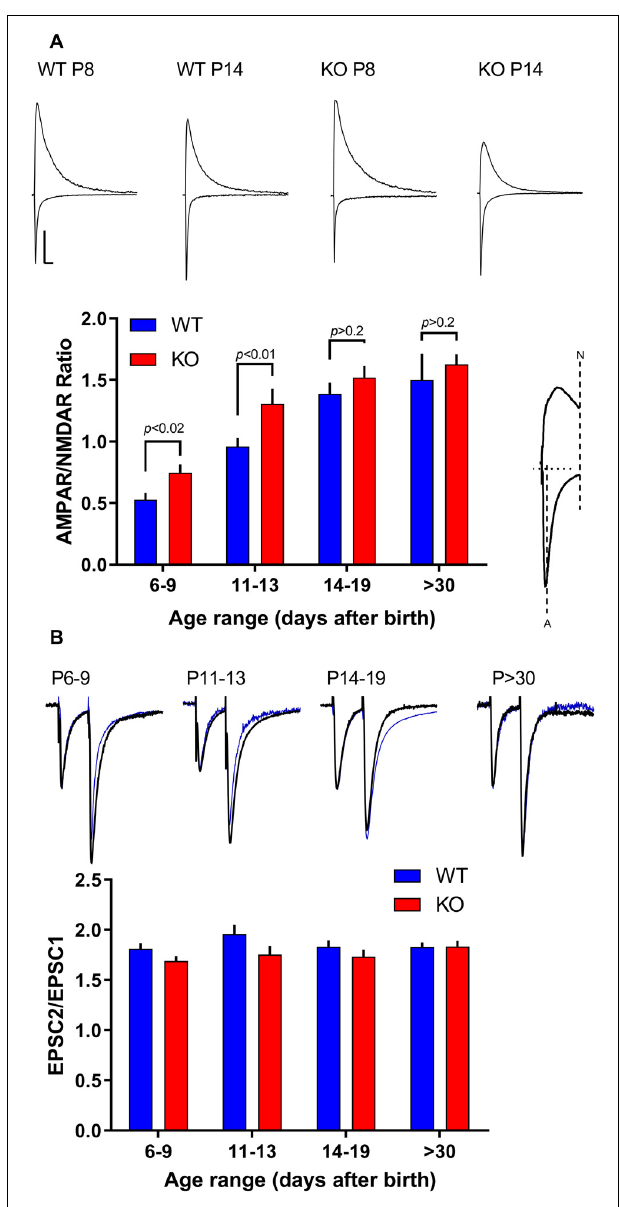
FIGURE 1 | Amplitude of AMPA-type glutamate receptor (AMPAR) and NMDAR-mediated evoked postsynaptic currents (EPSCs) during development. (A) Developmental profile of the AMPA Receptor to NMDA Receptor ratio. Top, sample traces of evoked responses from CA1 pyramidal cells recorded in voltage-clamp at − 60 mV or +40 mV from wild type (WT) and fragile X mental retardation protein (FMRP) knock-out (KO) slices as indicated. Scale bar = 50 ms and 50 pA. Bottom, population data of AMPAR to NMDAR ratio from WT neurons (blue bars) from slices P6–9 ( n = 17), P11–13 ( n = 42), P14–19 ( n = 47), and P > 30 ( n = 23). Red bars are from FMRP KO neurons from slices at same age groups (P6–9: n = 36; P11–13: n = 16; P14–19: n = 37; P > 30: n = 24). The amplitude of the AMPAR-mediated response was measured at the pick of the response at − 60 mV. The amplitude of the NMDAR response was measured at +40 mV 80 ms after the stimulus artifact as indicated in the example on the right. Student’s t -test p -values are indicated in the figure. (B) Paired-pulse facilitation (PPR) in FMRP KO and WT CA1 neurons at different ages as